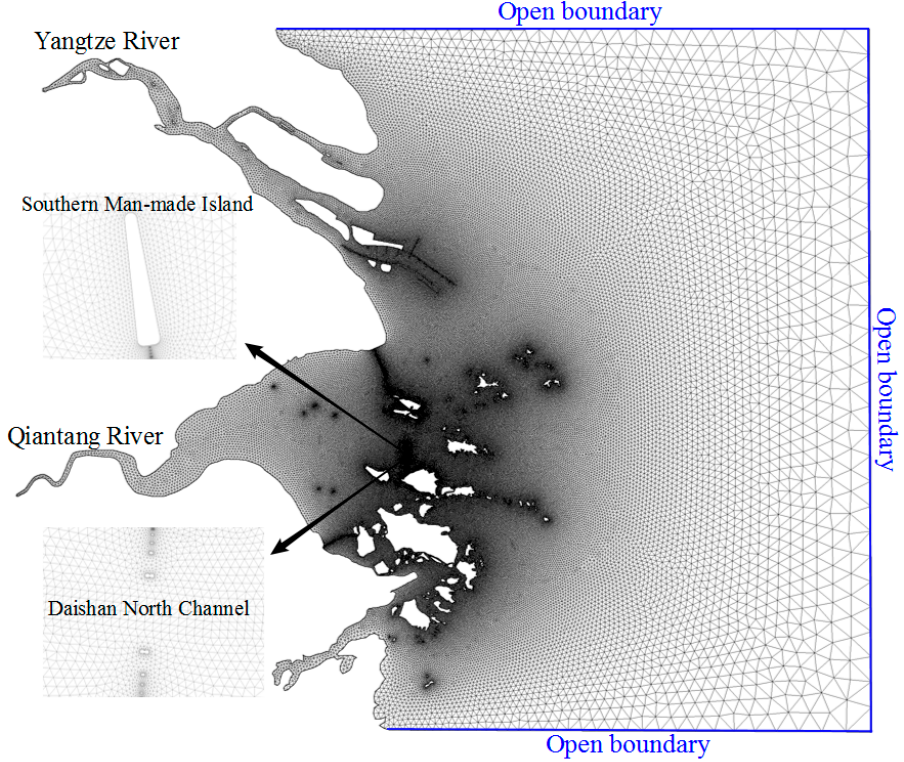
Figure 4. Mesh resolution of the numerical model.